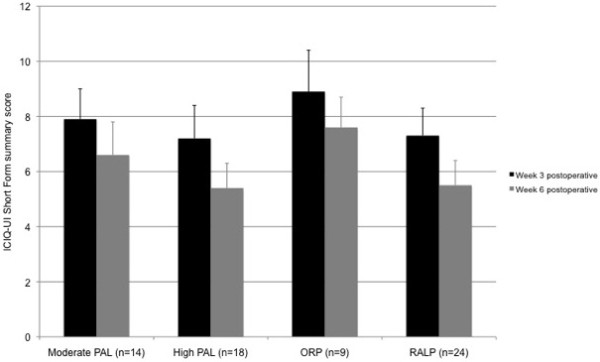
ICIQ-UI Short Form summary score at 3 and 6 weeks postoperatively, separated by preoperative physical activity category (moderate vs high physical activity level (PAL), using Armband data from week before surgery) and surgical group (mean + SE).